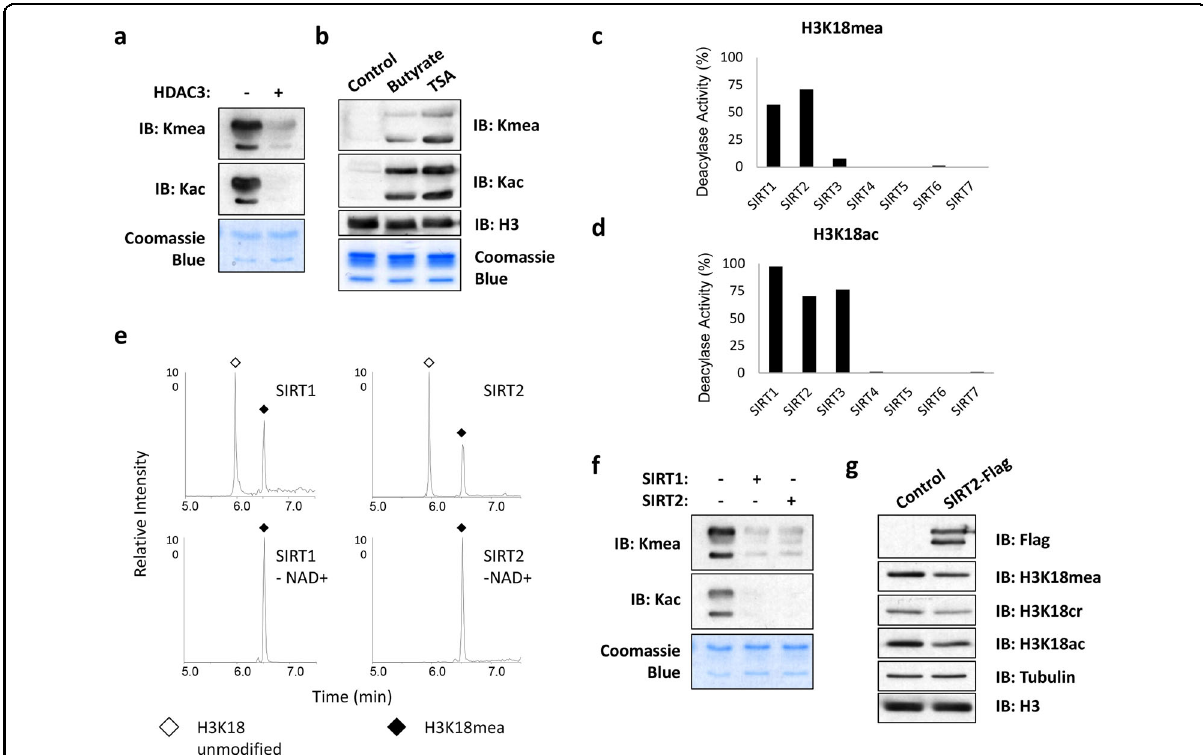
Fig. 7 SIRT1 and SIRT2 remove methacryl from Kmea. a Acid extracted HeLa histones were incubated with or without recombinant HDAC3 for 12 h at 37 °C. Samples were then analyzed by western blot. b HEK 293 T cells were treated for 24 h with either 10 mM sodium butyrate or 1 μ M TSA. The core histones were prepared by acid extraction method and then subjected to western blot analysis. c , d Quantitation of deacylase activity of SIRT 1-7 for in vitro screen using either H3K18mea peptide (c) or H3K18ac peptide (d) is shown. The deacylase activity percentage was calculated by dividing the area of the H3K18 unmodi fi ed chromatogram peak over the sum of the H3K18 unmodi fi ed and modi fi ed chromatogram peaks. e H3K18mea synthetic peptides were incubated with SIRT1 or SIRT2 in presence of reaction buffer with or without its cofactor NAD + . Chromatograms of each sample condition are shown. Open diamonds indicate the H3K18 unmodi fi ed peptide peaks. Filled diamonds indicate the H3K18mea peptide peaks. f Acid-extracted HeLa histones were incubated with or without recombinant SIRT1 or SIRT2 for 12 h at 37 °C. Samples were then analyzed by western blot. g HEK 293 T cells were transfected with either control empty pcDNA 3.1 vector or pcDNA 3.1 SIRT2-Flag. Whole cell lysates were prepared 48 h post-transfection and then subjected to western blot analysis with the indicated